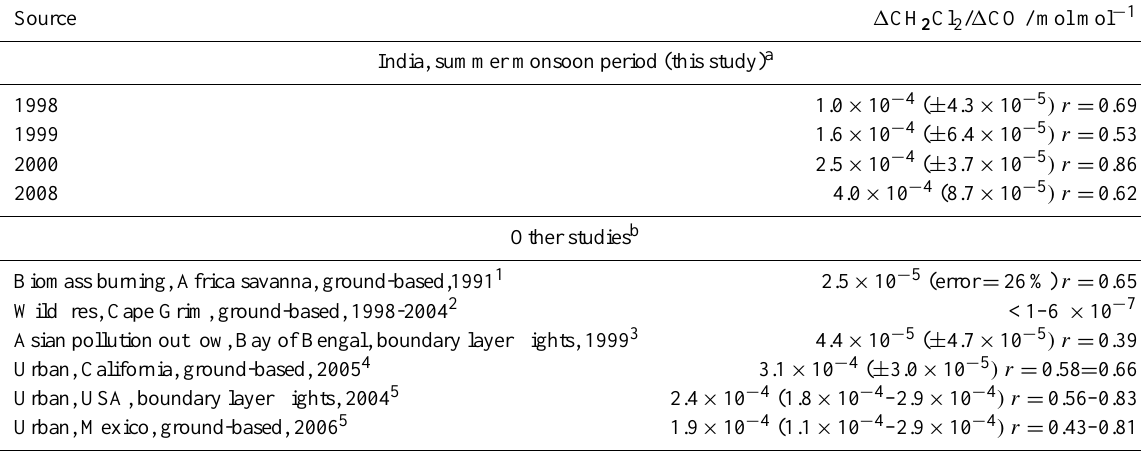
a CARIBIC fits are orthogonal distance regression fits using IGOR Pro software. b described by: emission source, location, sampling location, year of study 1 (Rudolph et al., 1995); 2 (Simmonds et al., 2006); 3 (Scheeren et al., 2002); 4 (Gentner et al., 2010); 5 (Millet et al., 2009).